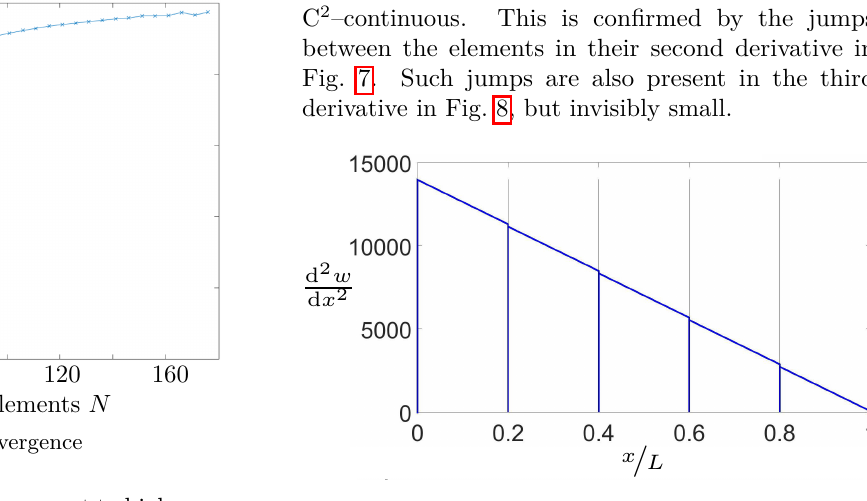
Table: Dimensions, loads and material parameters